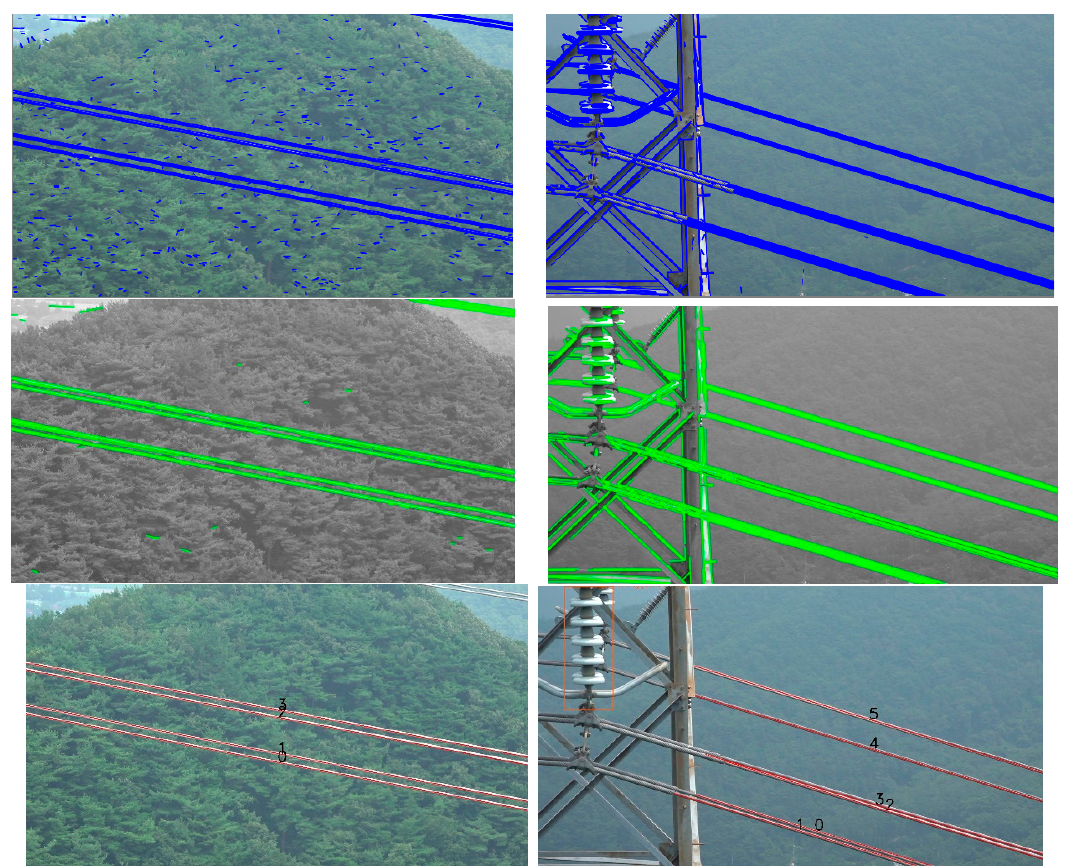
Figure 14. First row: Line Segment Detector (LSD), second row: edge drawing algorithm (EDLines), and third row: proposed scheme.